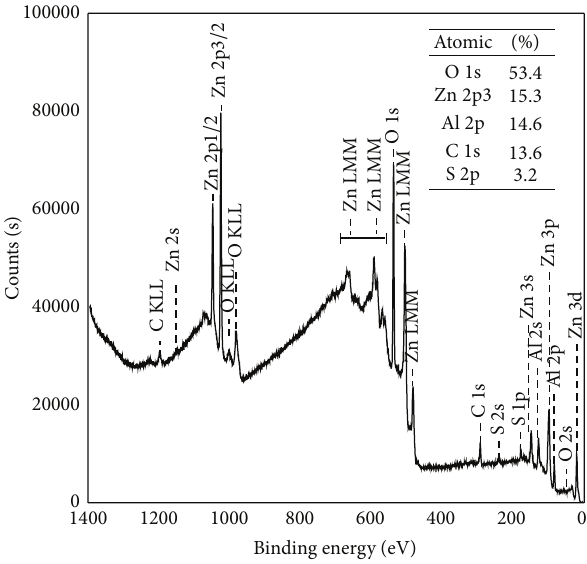
Figure 5: XPS survey spectrum of the as-deposited ZnO/ZnAl 2 O 4 film annealed at 700 ∘ C for